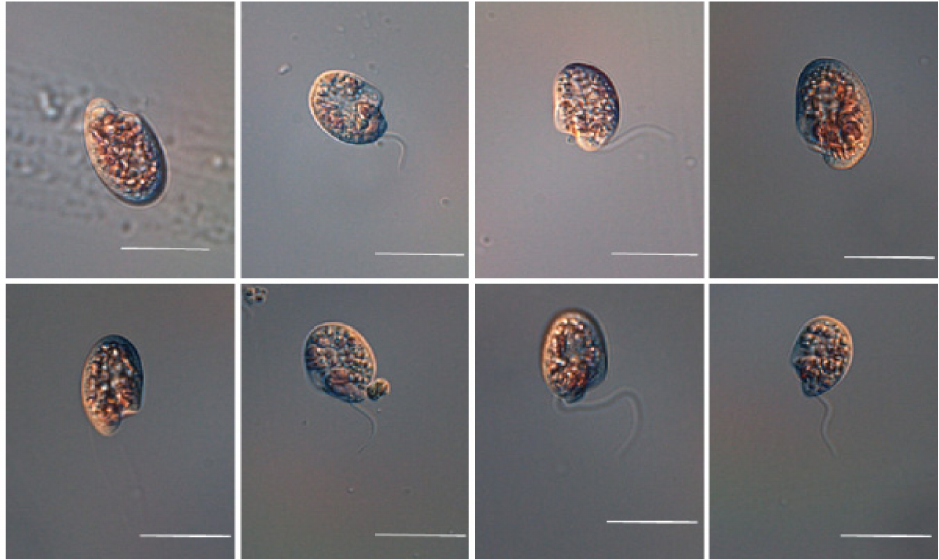
Figure 2. Micrographs of Oxyrrhis marina (OMGS 0105) using light microscopy. Scale bars = 20 µ m. The length and width of living cells of starved O. marina (n = 30) ranged 16.0–31.2 µ m (mean ± SD = 23.6 ± 4.2 µ m) and 8.0–19.2 µ m (mean ± SD = 13.8 ± 2.4 µ m), respec- tively, whereas live cells fed with Prorocentrum minimum (n = 15) measured 15.2–33.7 µ m (28.4 ± 4.64 µ m) and 15.6–24.0 µ m (18.9 ± 3.7 µ m) in length and width, respectively. Thus, the ratio of the cell length to width of living cells starved for 5 d (mean ± SD = 1.74 ± 0.23; range = 1.2–2.2; n = 30) was larger than that of cells fed with P. minimum (mean ± SD = 1.53 ± 0.17; range = 1.3–1.8; n =